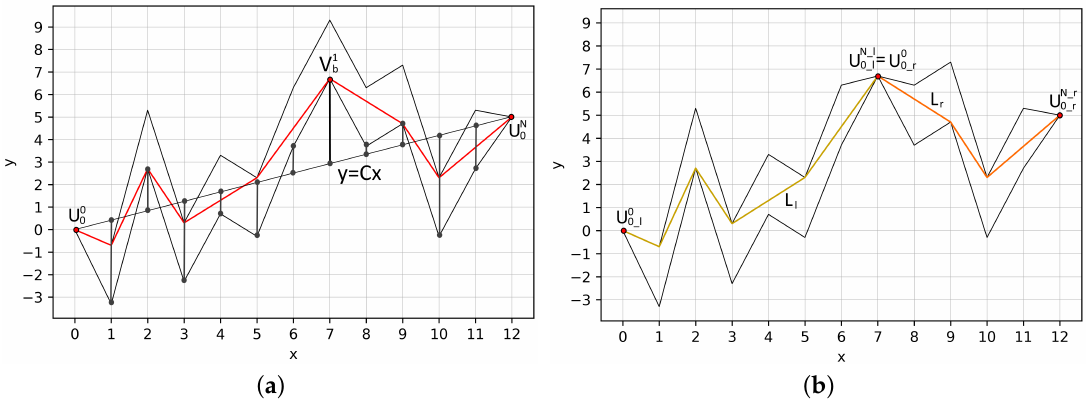
Figure 10. ( a ) Distances between the line y = Cx and interior vertices of the bottom tube boundary, extremal curve L (red); ( b ) extremal curves L l (yellow) of the left subtube and L r (orange) of the right